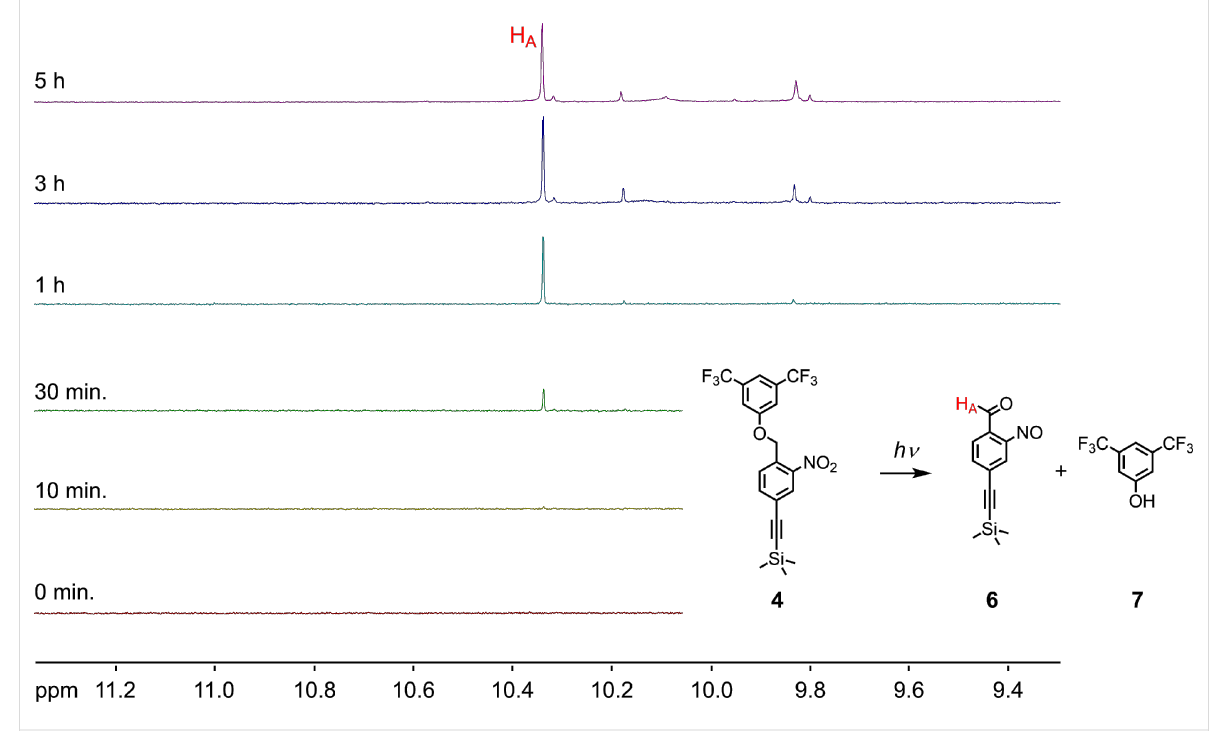
Figure 2: Qualitative photocleavage experiment of the monomer 4 irradiated at 355 nm inside the NMR spectrometer. The background displays the increase of the aldehyde signal of the 2-nitrosoaldehyde 6 with increasing light exposure.